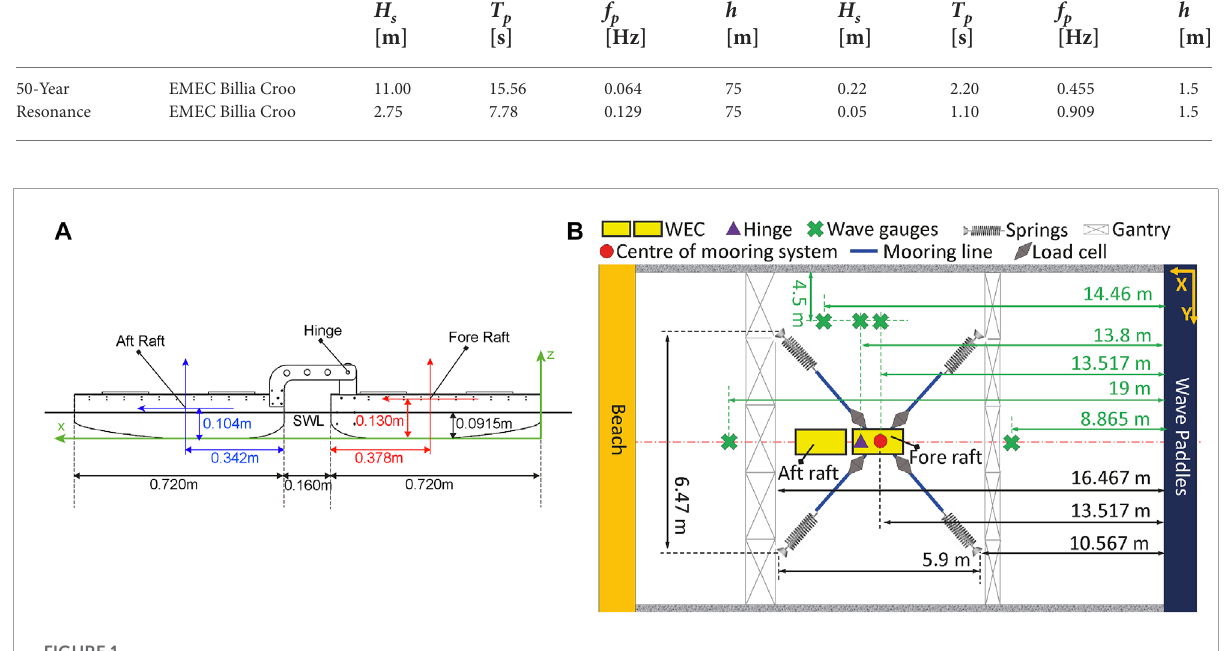
FIGURE 1 Diagrams of the device dimensions (A) and the experimental setup (B) in the COAST